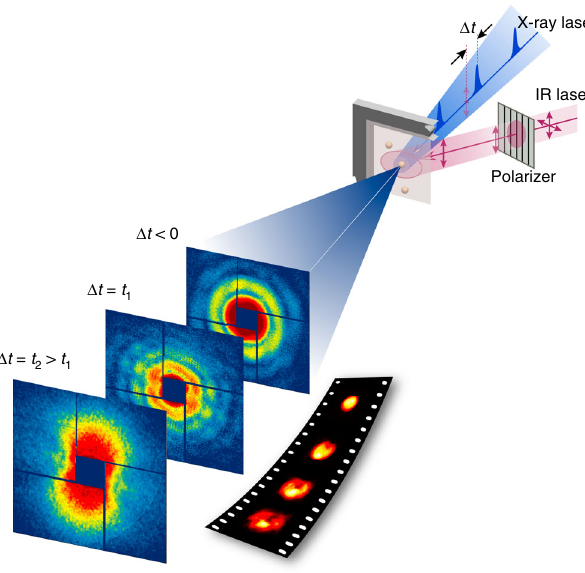
Fig. 1 Single-shot pump-probe imaging using femtosecond X-ray laser pulses. A femtosecond IR laser irradiates Au nanoparticles, driving the after planned delays to track the reaction on the picosecond time scale.